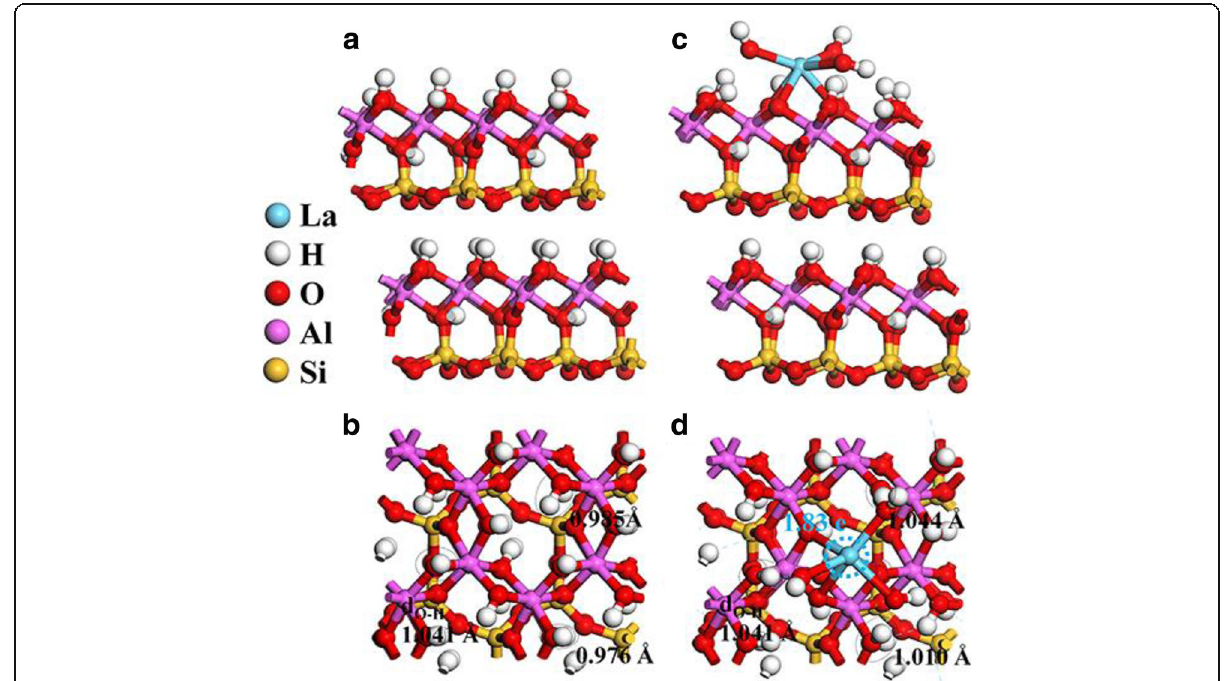
Fig. 7 Geometric structure of a side view and b top view of HNT, and c side view and d top view of La-HNT